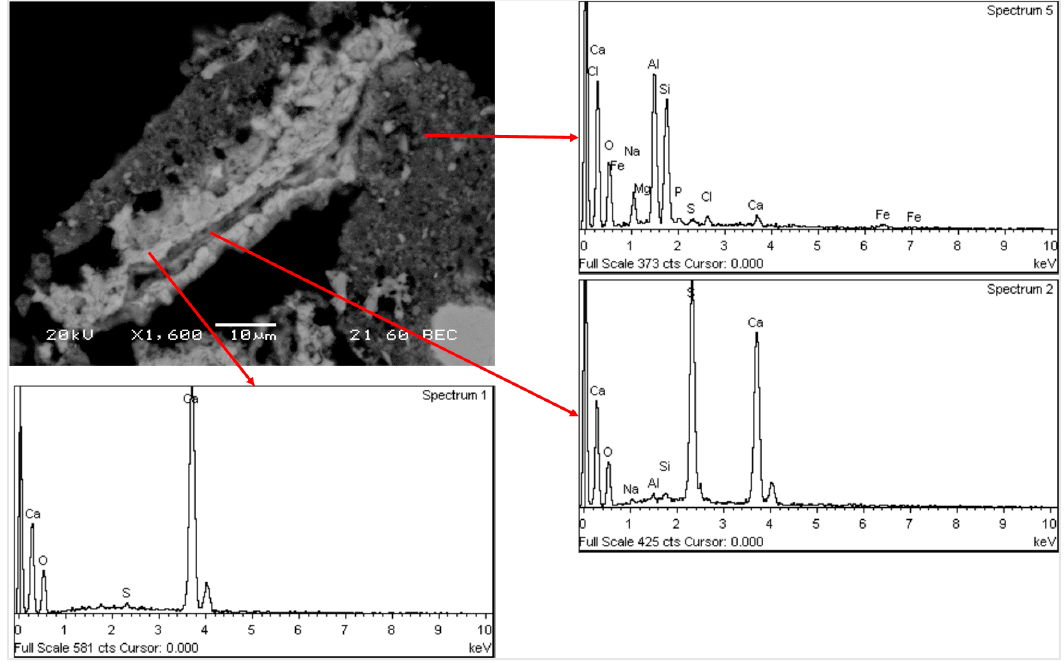
Figure 8. Scanning electron microscope (SEM image of the matrix of the residue after